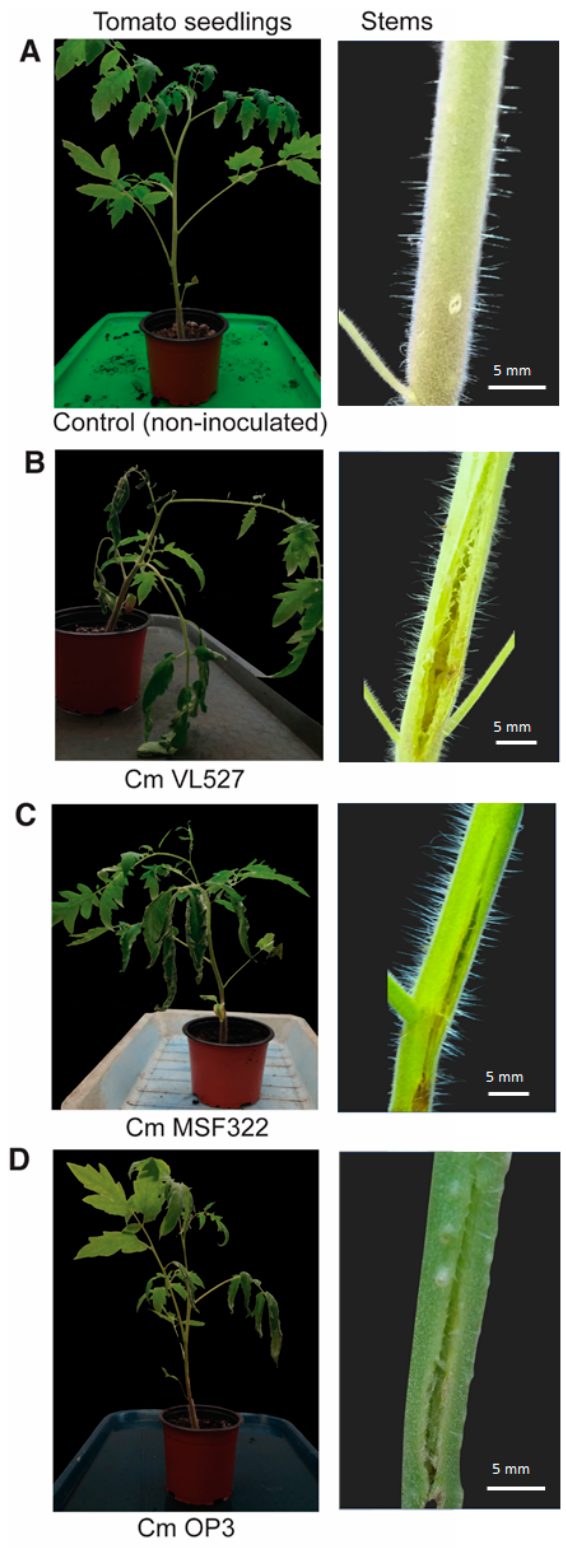
Figure 1. Experimental assays for pathogenicity of the Chilean strains VL527, MSF322 and OP3 in tomato seedlings. Disease symptoms of tomato seedlings 21 days after inoculation with strains VL527 ( B ), MSF322 ( C ), OP3 ( D ), belonging to three di ff erent phylogenetic clades of C. michiganensis subsp. michiganensis , and mock inoculated, non-inoculated control ( A ). Tomato seedlings were stabbed into the stems at 1 cm from cotyledons (red arrow), using a toothpick dipped in a fresh bacterial